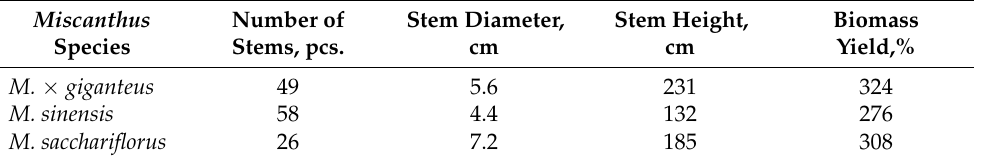
Table 2. Parameters of various miscanthus species after 3 years of cultivation. Miscanthus Number of Species Stems,